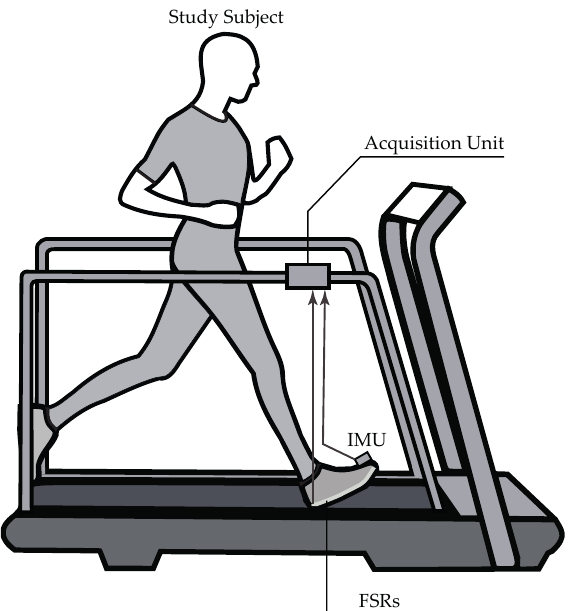
Figure 6. Experimental setup. Each subject was instrumented on their dominant/affected side with a custom FSR-equipped insole and an IMU placed on the dorsal side of their foot. Foot motion data were captured by using a Raspberry Pi running ROS to ensure synchronized data